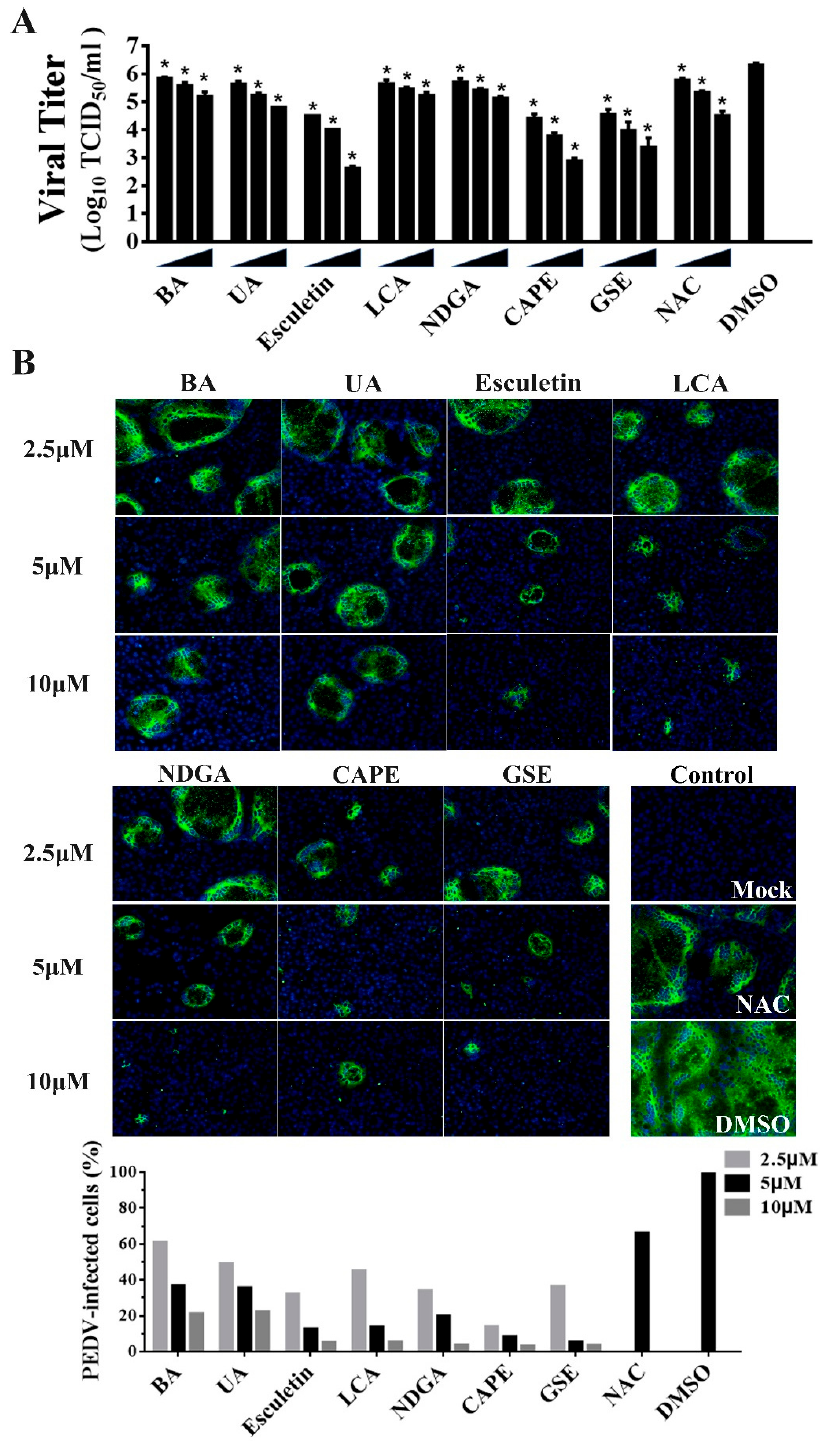
Figure 5. The inhibitory effects of seven kinds of antioxidants on PEDV infection on Vero cells. Vero cells were incubated with seven antioxidants at various concentrations (2.5, 5, and 10 µ M) for 1 h, and then infected with wild-type PEDV at a MOI of 0.01. ( A ) At 20 h post-infection, the titers of infected cell cultures were determined by TCID 50 . NAC (50, 100, and 200 µ M) and DMSO were used as the positive and negative controls. Data are presented as means ± SDs from three independent experiments. ( B ) PEDV S protein expression (green) in infected cells was analyzed by IFA using anti-PEDV S mAb 4B2. Nuclei (blue) were stained with DAPI. The percentage of PEDV-infected cells was counted based on the IFA results (bottom). NAC (50 µ M) and DMSO were used as the positive and negative controls, * p <